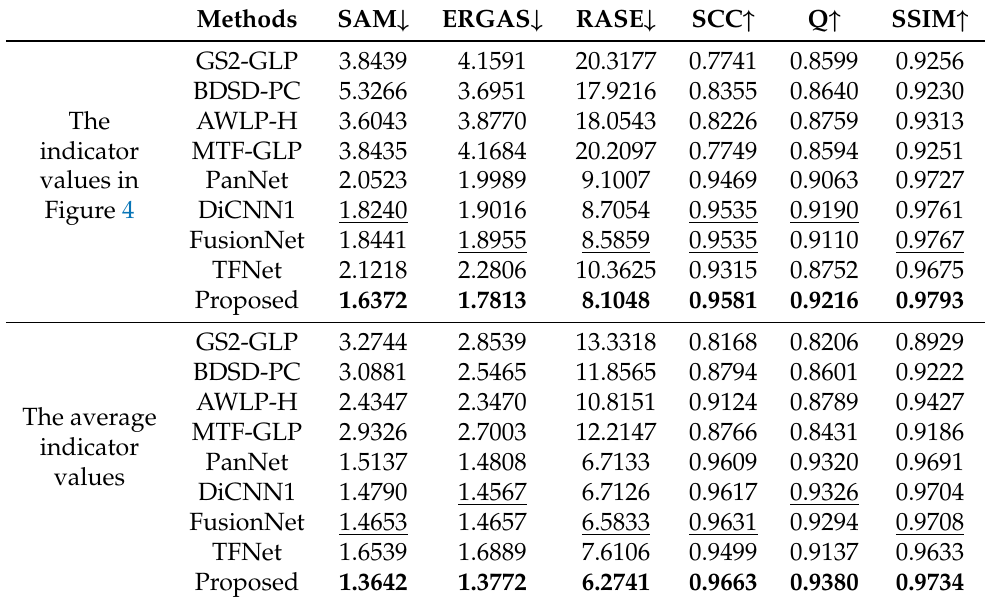
Table 7. Comparison of indicator evaluation results on the reduced-resolution GeoEye-1 dataset.